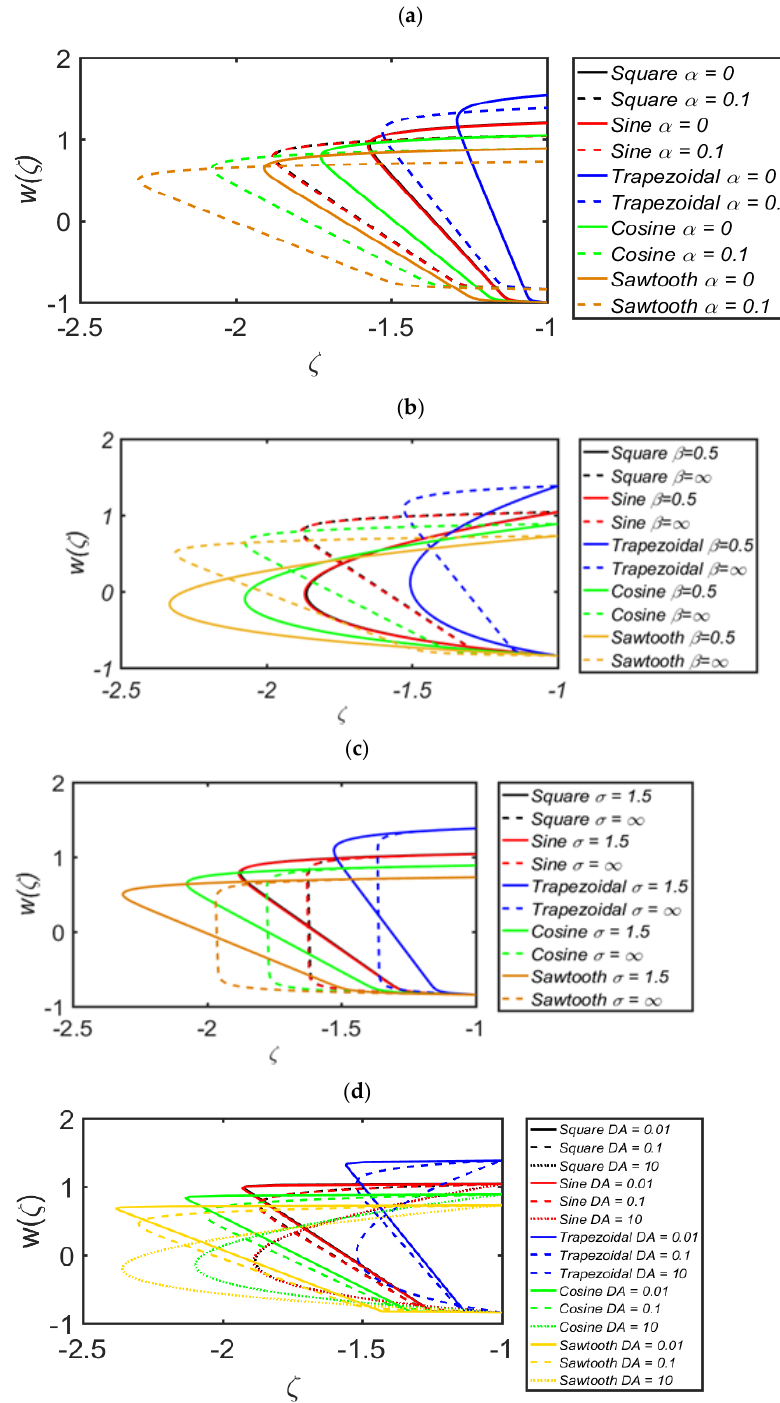
Figure 3. ( a ) The velocity distribution 𝑤(𝜍) for curvature parameter (𝜎) at 𝑞 = −3,𝐷𝐴 = 0.01,𝛼 = 0.1,𝛽 = 0.1,and 𝜙 = 0.2. ( b ) The velocity distribution 𝑤(𝜍) for viscoelastic parameter (𝛽) at 𝑞 = −3,𝐷𝐴 = 1,𝛼 = 0.1,𝜎 = 1.5,and 𝜙 = 0.2. ( c ) The velocity distribution 𝑤(𝜍) for non-uniform pa- rameter (𝛼) at 𝑞 = −3,𝐷𝐴 = 0.01,𝜎 = 1.5,𝛽 = 0.1,and 𝜙 = 0.2. ( d ) The velocity distribution 𝑤(𝜍) for porosity parameter (𝐷𝐴) at 𝑞 = −3,𝛽 = 0.1,𝛼 = 0.1,𝜎 = 1.5,and 𝜙 = 0.2.